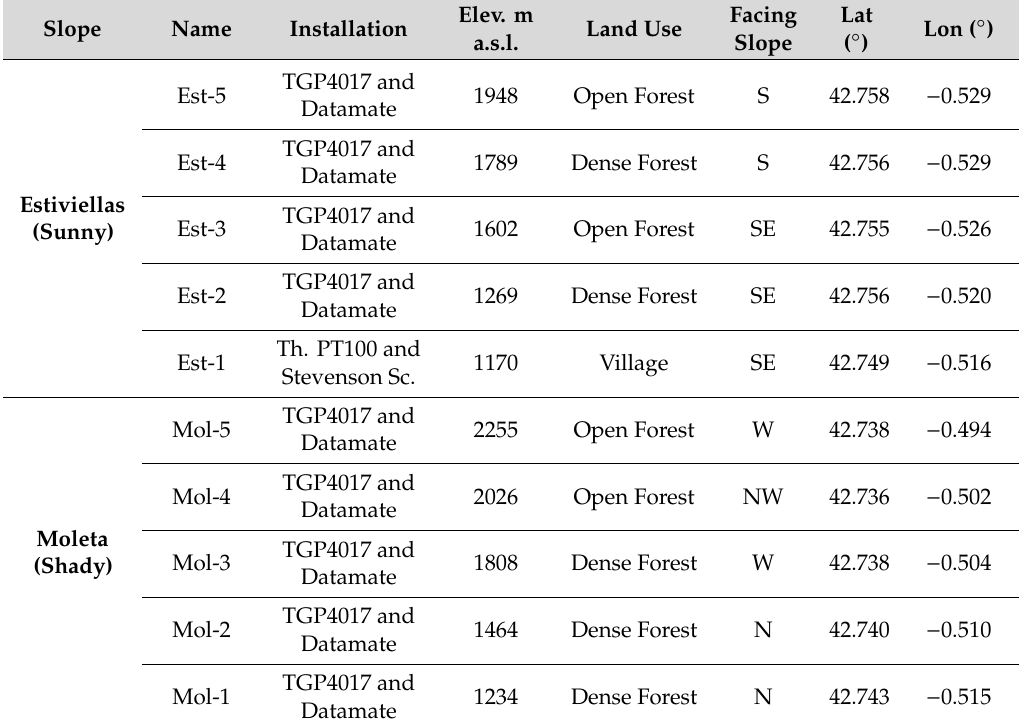
Table 1. Main characteristics of the monitored locations. Elevation is expressed in meters above sea level (m a.s.l.). Latitude and Longitude are expressed in geographical